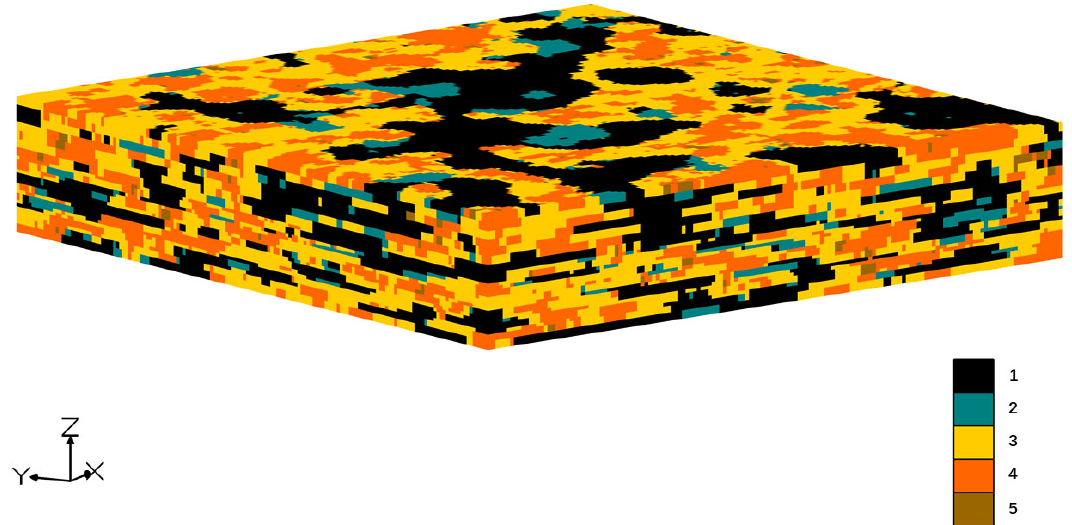
Figure 4. Simulated results of heterogeneous lithological distribution in the study area. Note: 1 ‐ Mudstone; 2 ‐ Silty mudstone; 3 ‐ Fine sandstone; 4 ‐ Medium sandstone; 5 ‐ Coarse sandstone.